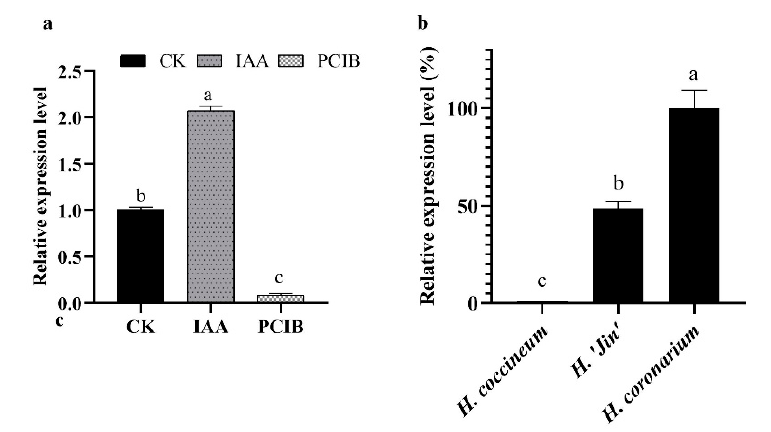
Figure 6. mRNA levels of HcMYB132 and emission level of eucalyptol under IAA and PCIB treat- ment. ( a ) transcript levels of HcMYB132 under IAA and PCIB treatment; ( b ) mRNA levels of HcMYB132 in IAA and PCIB treated flowers. Error bars indicate SD of 3–5 repeats, and lowercase letters indicate significant differences using the LSD test ( p < 0.01).